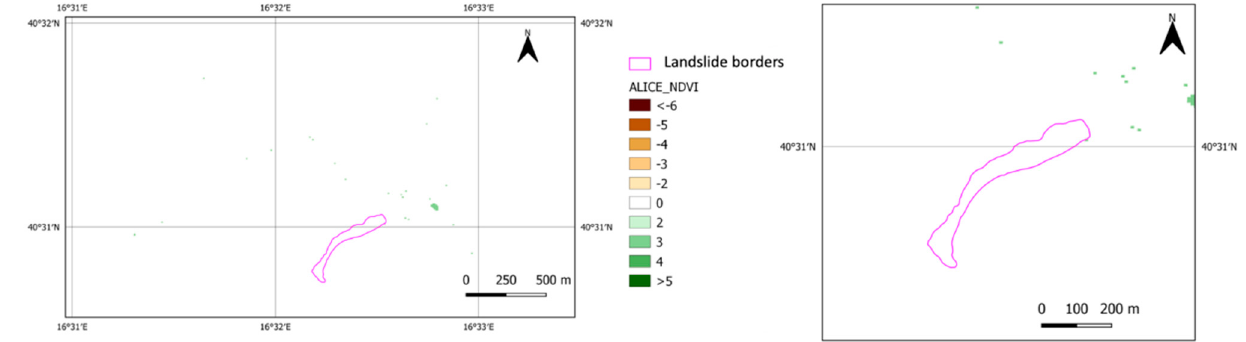
Figure 7. ⊗ NDVI ( x,y,t ) computed for the Sentinel-2 L1C image of 9th February 2018 at 09.40 GMT. No changes (positive and/or negative) have been detected in the analyzed area as